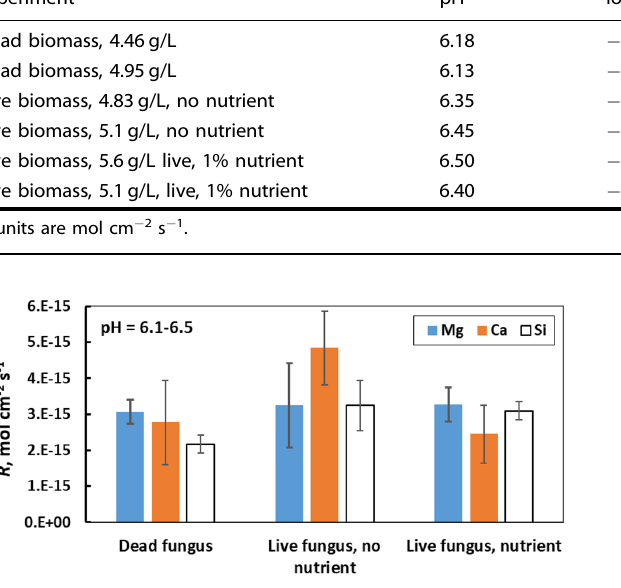
Table 2. Results of fungus batch experiments (0.1 M NaCl). Experiment